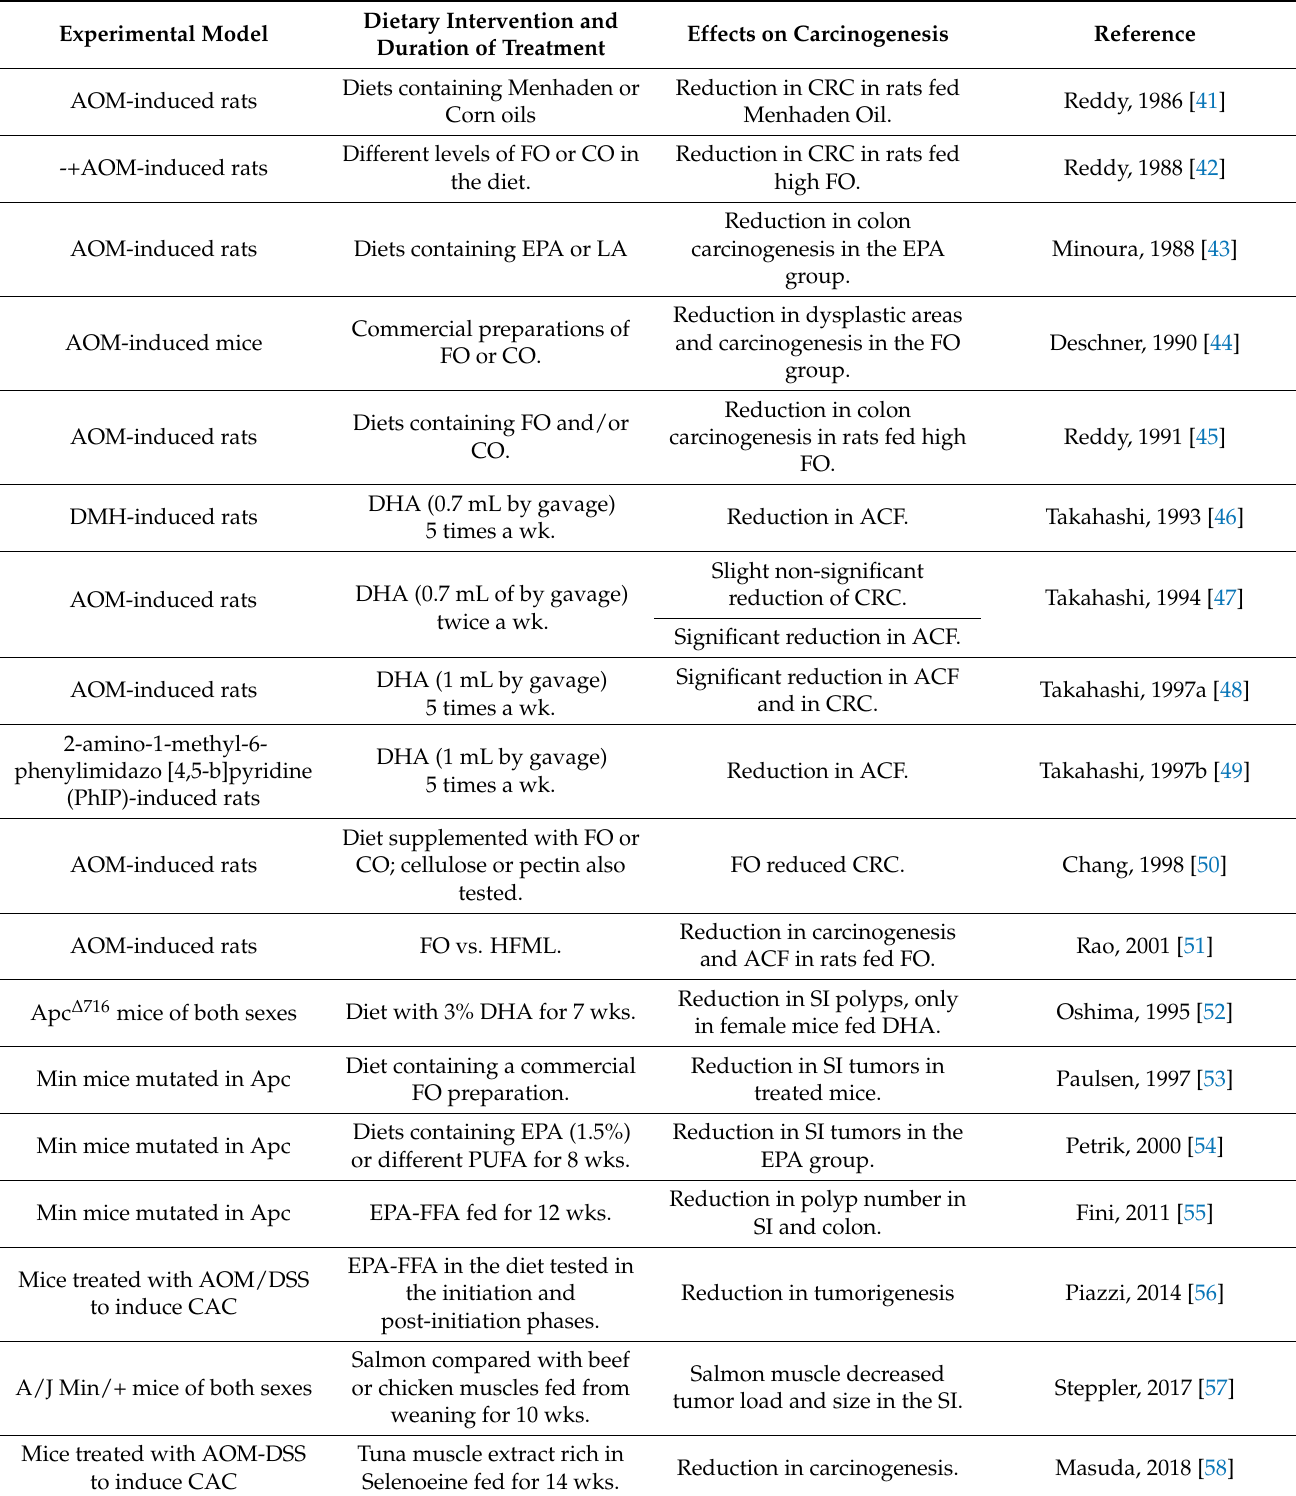
Table 4. Effects of fish or its components on different animal models of colorectal